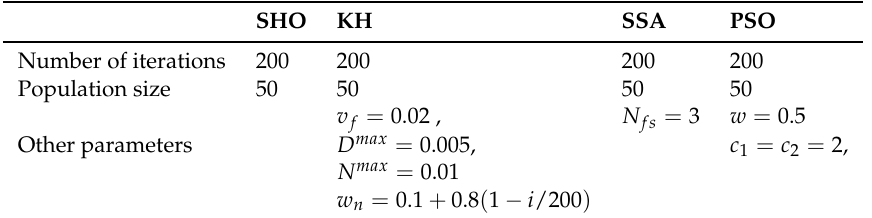
Table 2. Parameters configuration for each